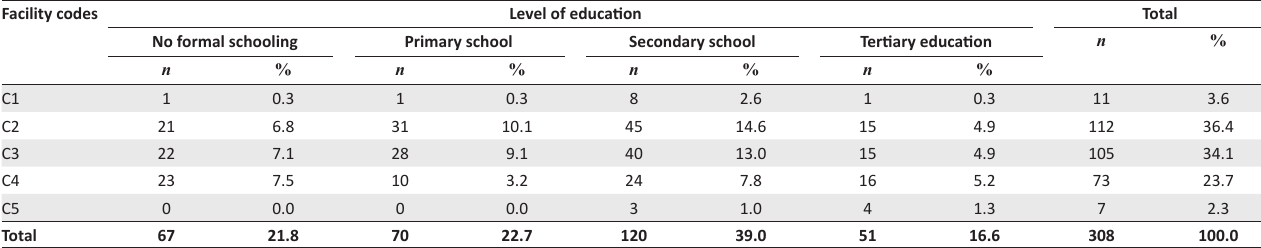
TABLE 1: Level of education of respondents per